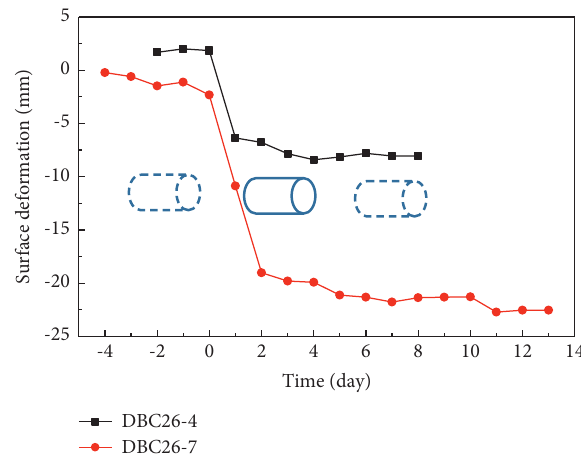
Figure 8: Deformation of monitoring points in section DBC26.